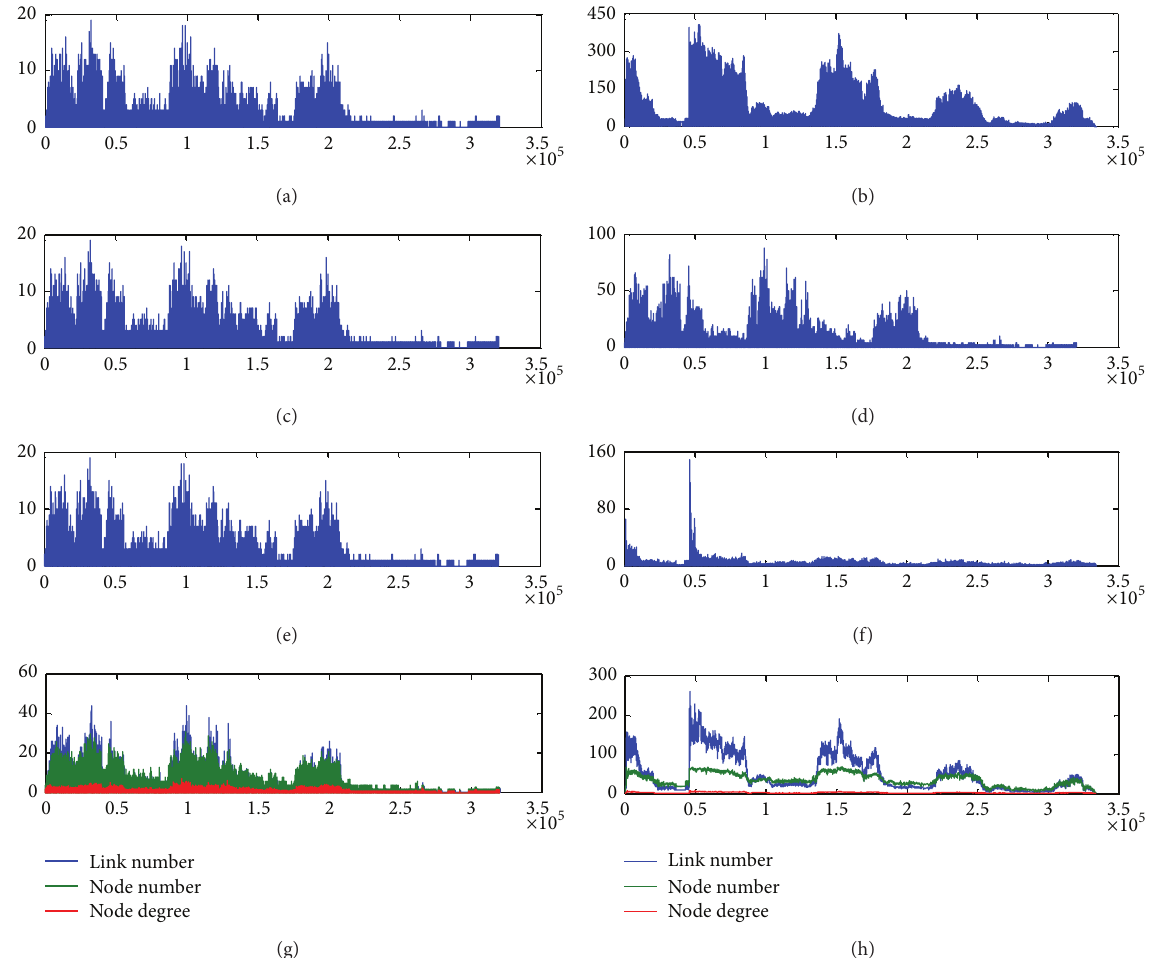
Figure 6: Description of two datasets. SIGCOMM09 records the discrete contact time among nodes, while INFOCOM06 records the continuous contact time. (a) Total link number (SIGCOMM09), (b) total link number (INFOCOM06), (c) link add (SIGCOMM09), (d) link add (INFOCOM06), (e) link remove (SIGCOMM09), (f) link remove (INFOCOM06), (g) network feature (SIGCOMM09), and (h) network feature